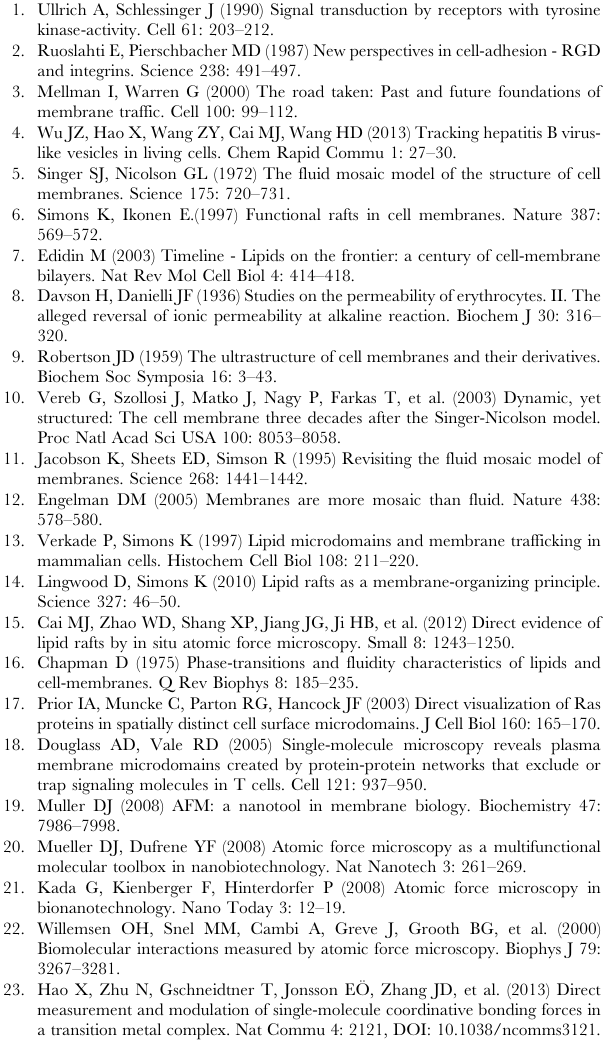
Figure S9. Western blot analysis of protein differential distribu- tion in Hela cells. (A) Hela cells treated with PBS (ctrl), protease mixture and 0.1% Triton X-100/protease mixture was used